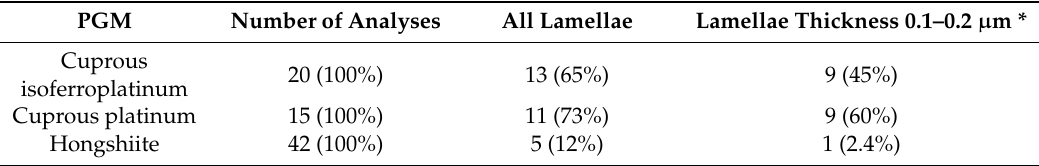
Table 2. The frequency of occurrence of PGMs containing Ru-Os-Ir lamellae in grain No. 1. PGM Number of Analyses All Lamellae Lamellae Thickness 0.1–0.2 µ m * Cuprous 20 (100%) 13 (65%) 9 (45%) isoferroplatinum Cuprous platinum 15 (100%) 11 (73%) 9 (60%) Hongshiite 42 (100%) 5 (12%) 1